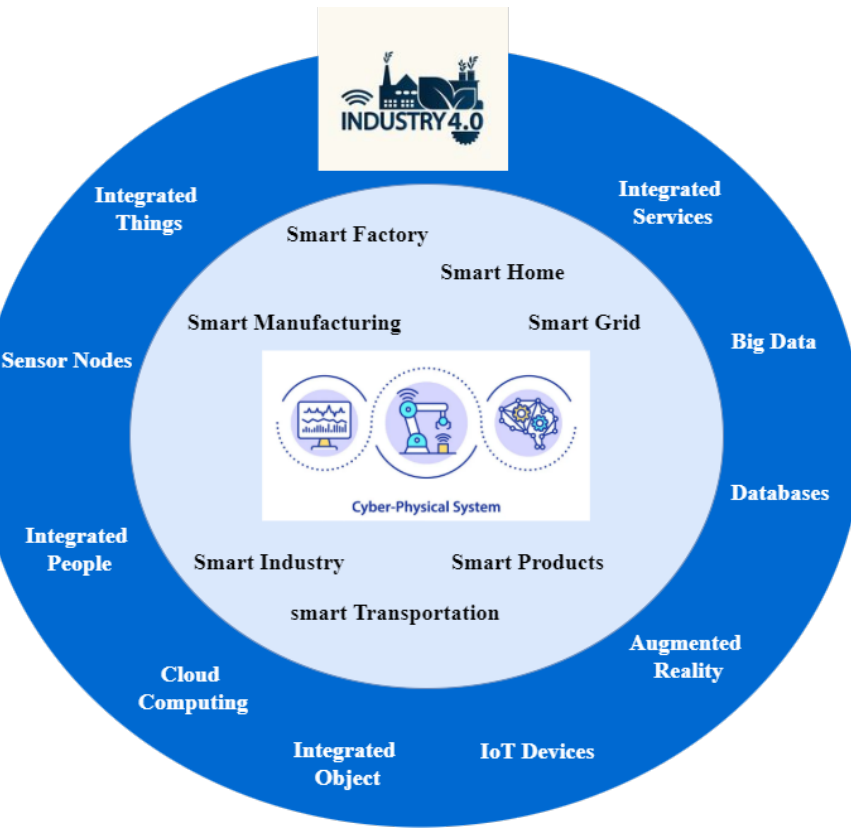
Figure 3. CPS system–integration of IoT, wireless devices, and people in Industry